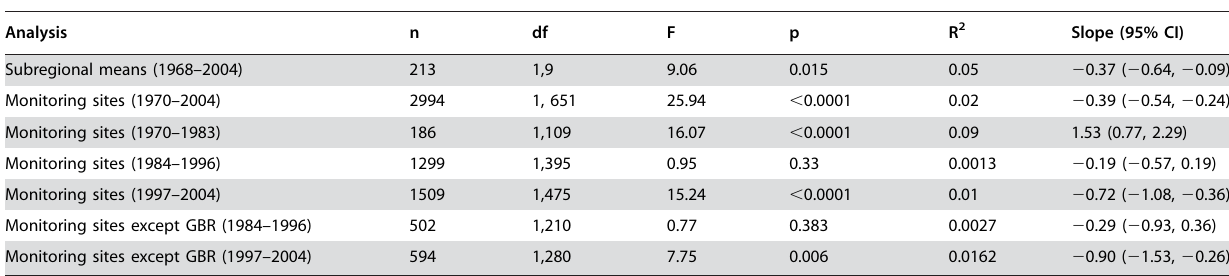
Table 1. Results of linear repeated measures regression analyses on the relationship between coral cover and time in the Indo-